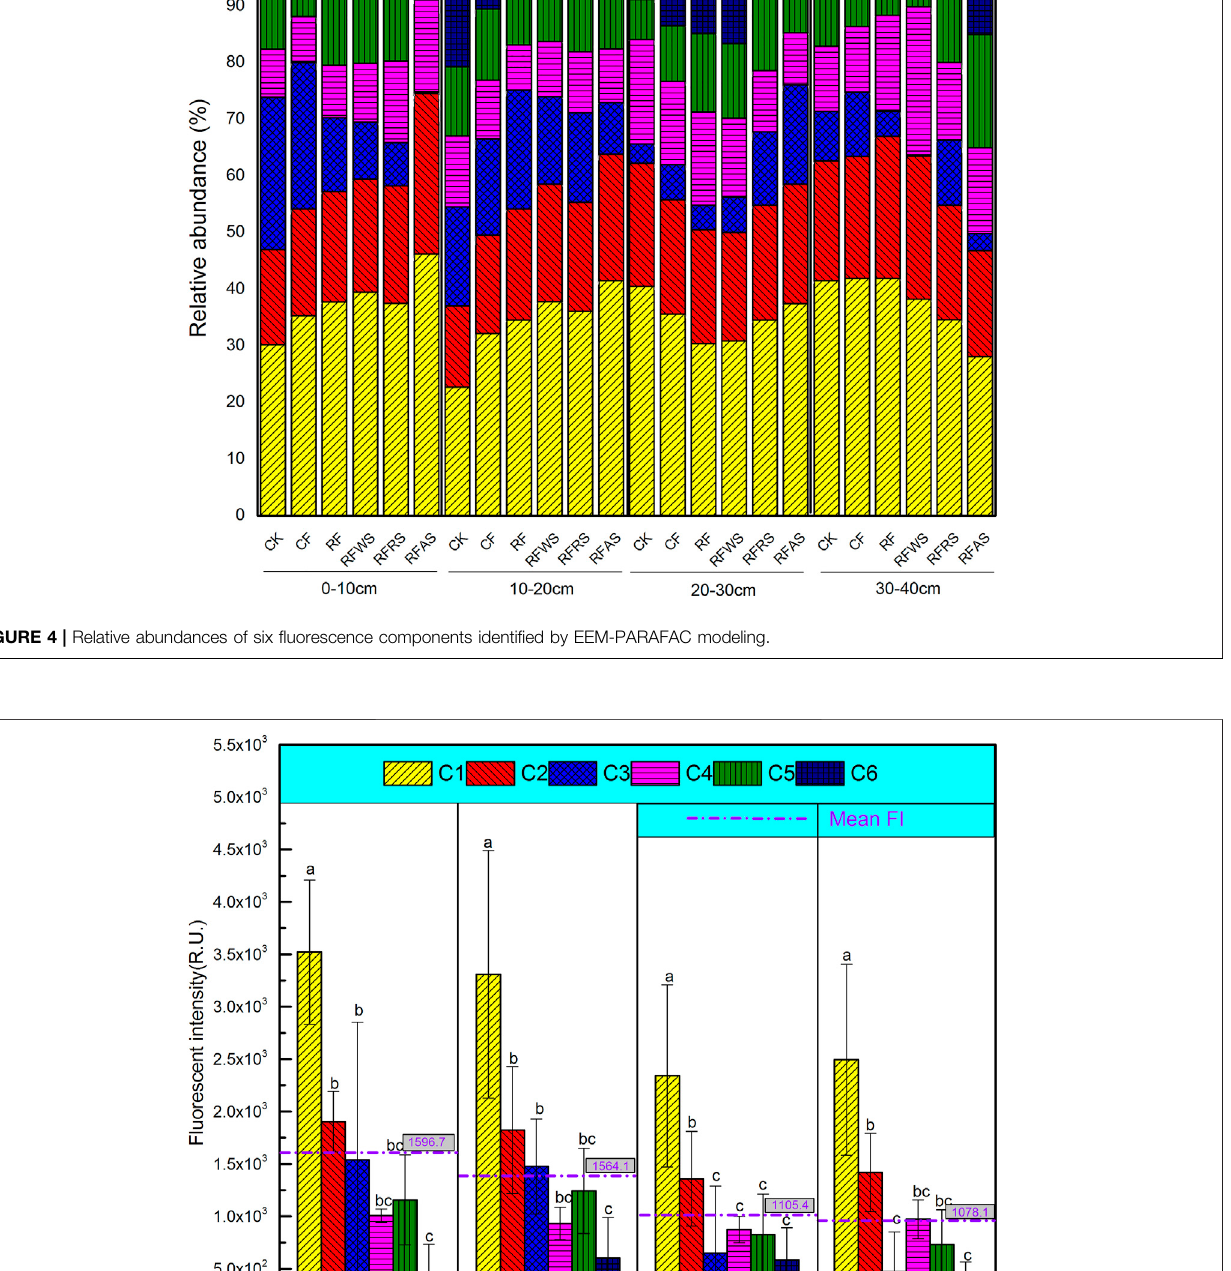
Frontiers in Environmental Science |